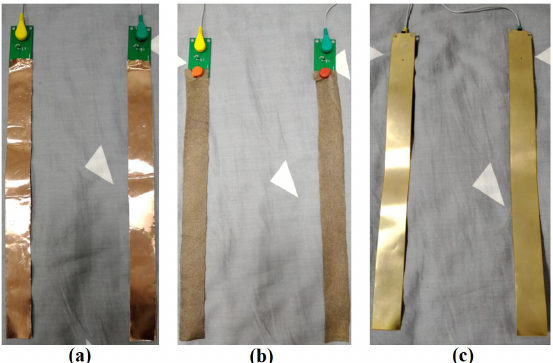
Figure 2. Three pairs of electrodes made of different materials: ( a ) copper foil tape, ( b ) conductive textile, ( c ) FPC.